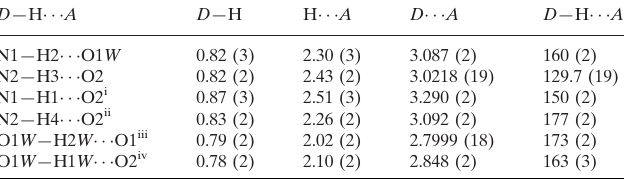
Hydrogen-bond geometry (A˚ , (cid:3)